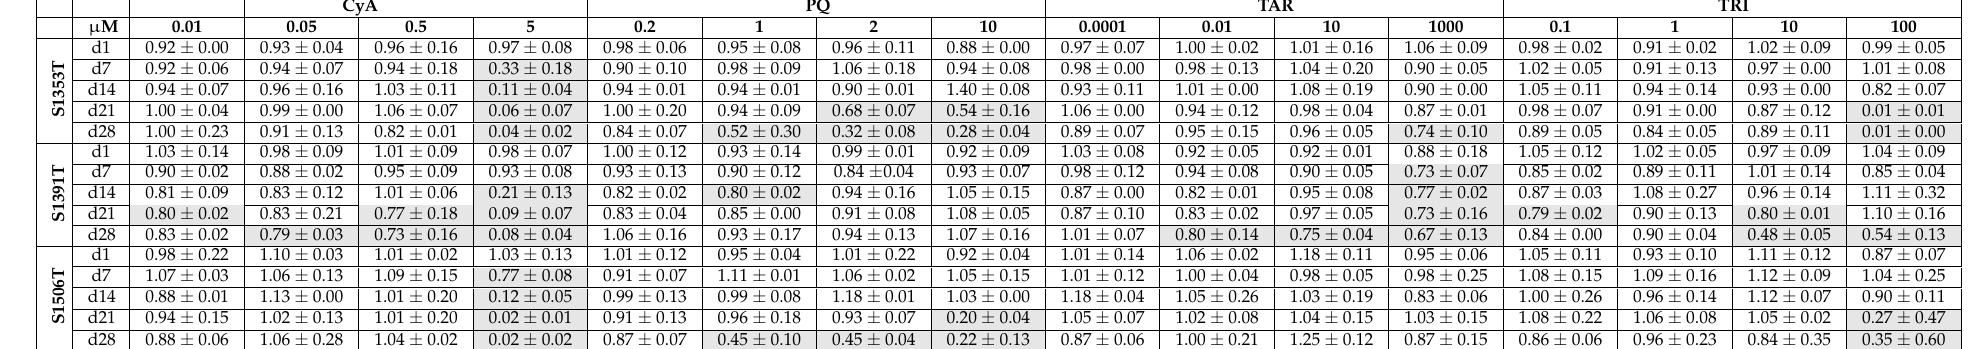
Table 3. Inter-donor variability regarding the effect of drug/chemical concentration and time of exposure on the cholestatic index